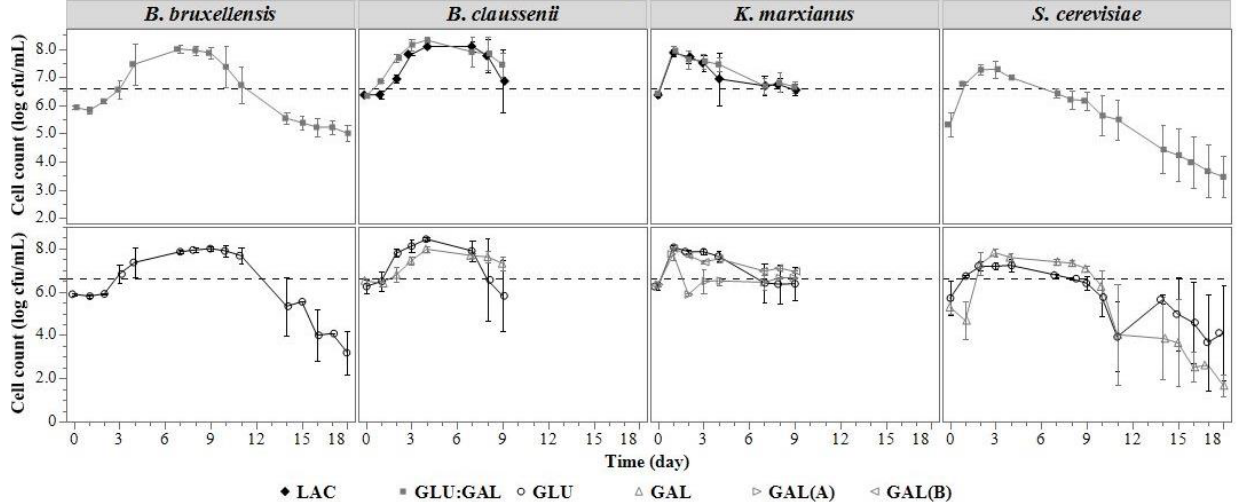
Figure 3. Cell concentrations of fermentates containing sugars associated with acid whey, as obtained by plating on potato dextrose agar; fermentates were held at 25 °C and subjected to shaking at 185 rpm. Top: lactose (LAC); 1:1 ratio of glucose and galactose (GLU:GAL). Bottom: glucose (GLU); galactose (GAL). Dashed lines indicate the intended cell concentration of each fermentate at the moment of inoculation. Error bars represent the standard deviations of three biological replicates, with the exception of K. marxianus , for which a fourth replicate was included. The results of K. marxianus in GAL have been subcategorized into treatments GAL(A) and GAL(B), based on the trends observed in this treatment’s density results.